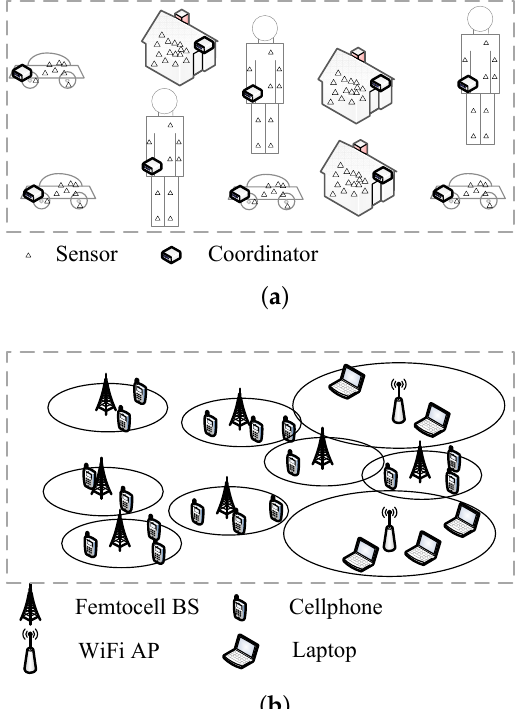
Figure 1. Scenarios for randomly-deployed small star networks (SSNs): ( a ) sensor clusters; ( b ) femtocells and WiFi